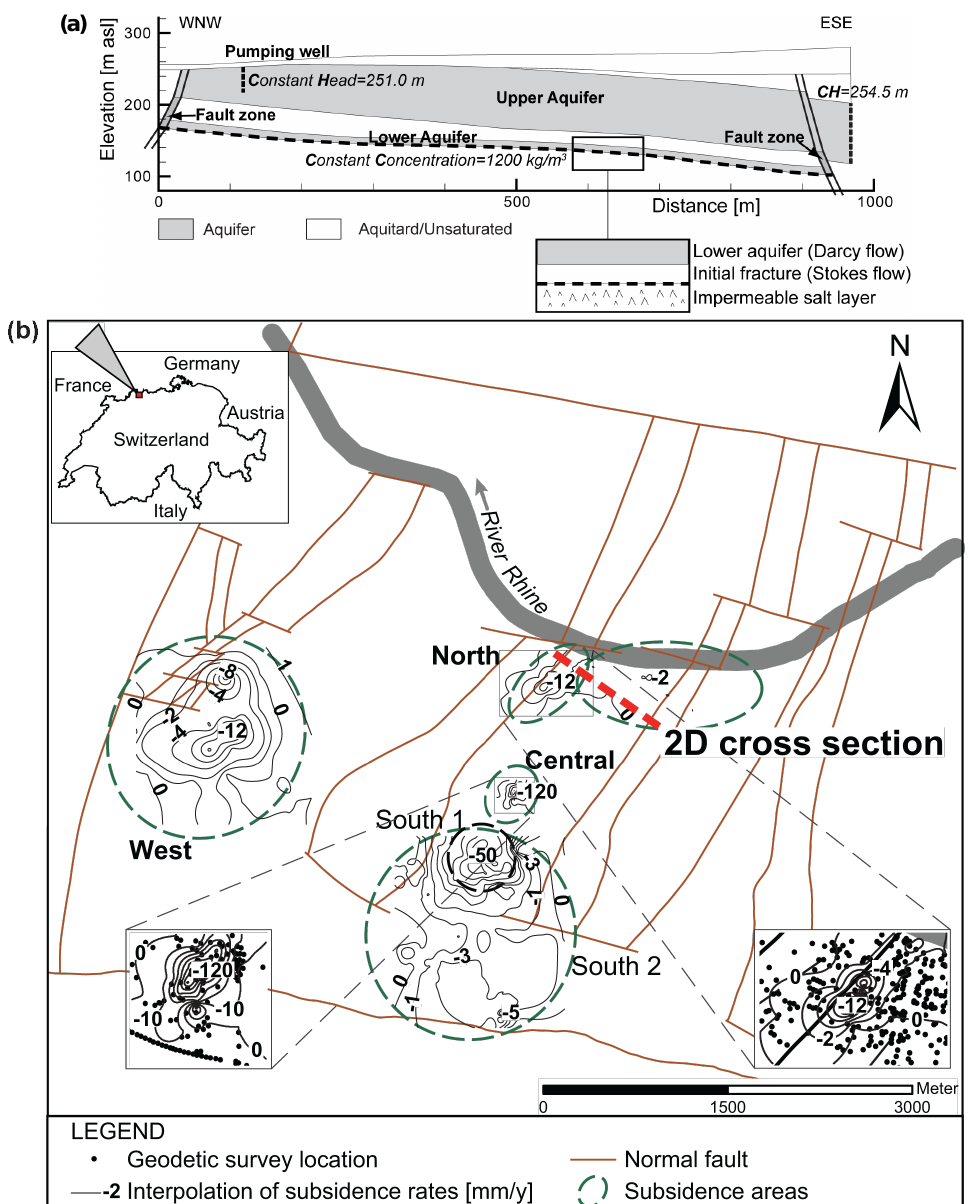
Figure 1. (a) Domain and boundary conditions of the 2-D cross section, and conceptual model for simulation of the dissolution process within the (initial) fracture. (b) Map of the study area in northwestern Switzerland with location of 2-D cross section. Interpolation of subsidence rates are between 1975 and 2000 (averaged over 25years), with focus on central (lower left panel) and northern (lower right panel) subsidence areas,